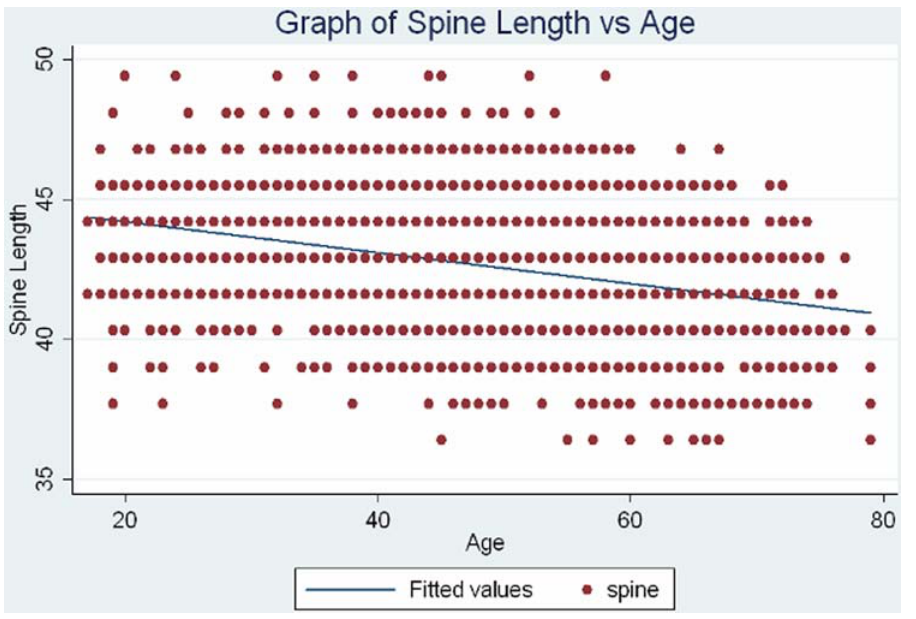
Figure 4. Graph of Spine Length vs. Age (showing line of best fit). The relationship between spine length and age is shown. Age accounted for 11% of the variation in spine length affecting the distribution in our sample. This variation was reduced to 8% after subjects over 70 years of age were removed.